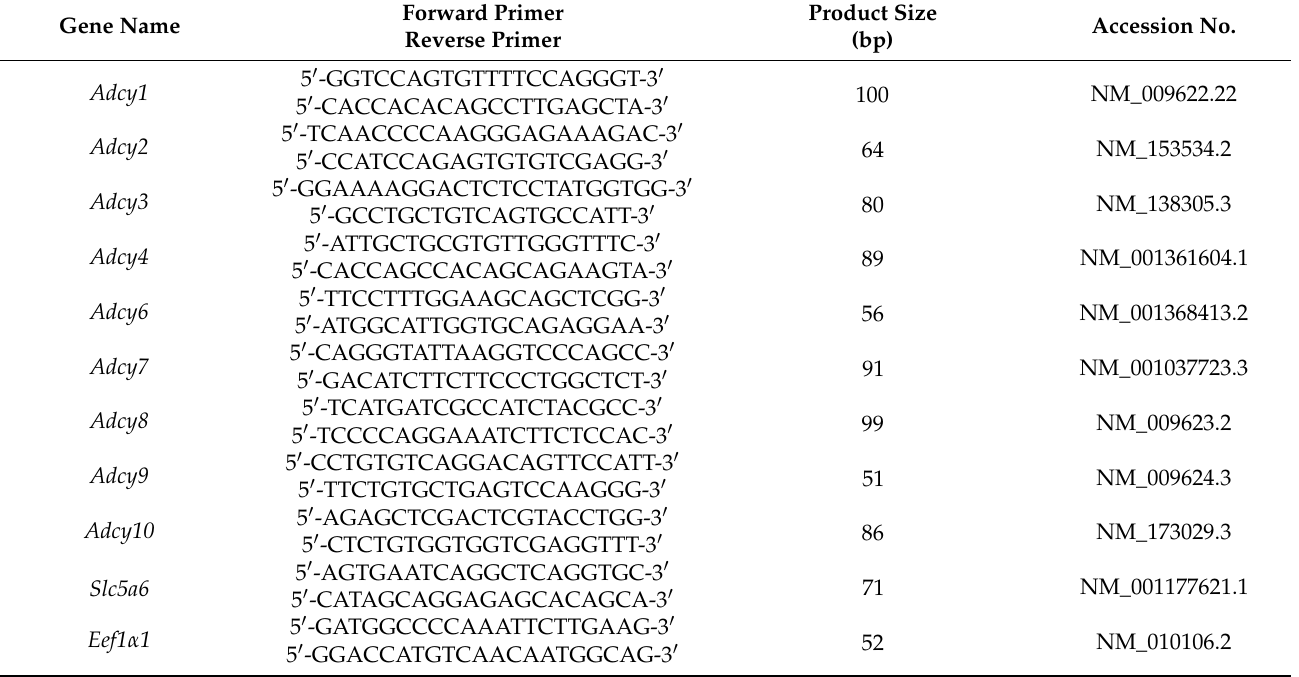
Table 2. Nucleotide sequences of primers used for